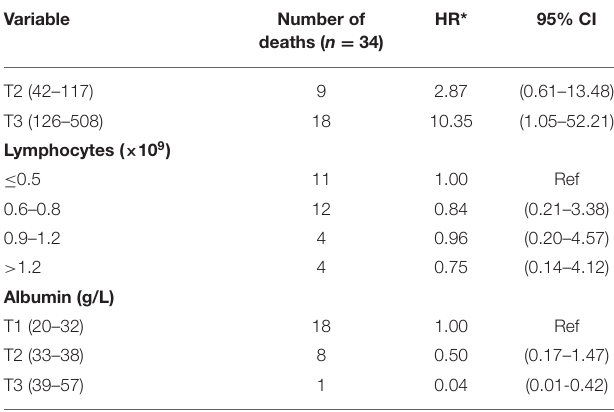
laboratory findings: decreased lymphocytes, increased CRP,